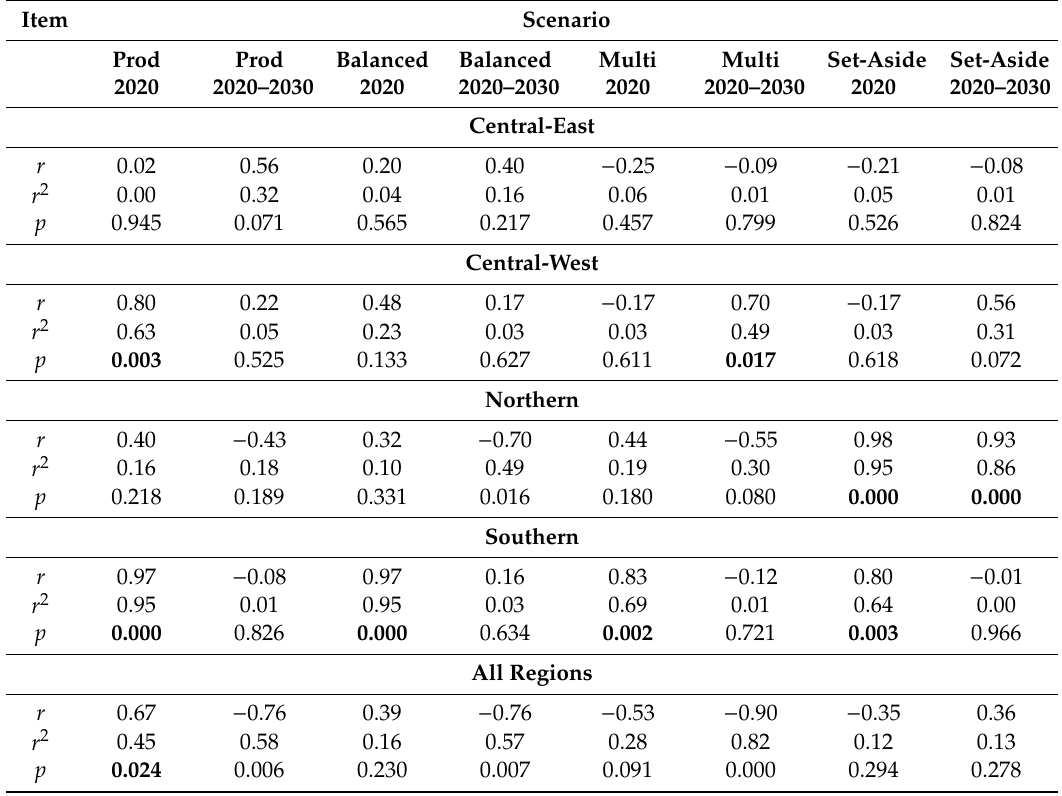
Table 6. Pearson correlation for the deviation of roundwood harvest and net forest emissions from the BAU-only scenario in the considered scenarios in 2000–2030 ( r ), coe ffi cient of determination ( r 2 ) and p -values for the correlation * (positive correlation implies that the increase in harvest occurs together with the increase in net forest emissions, and negative correlation implies that the increase in harvest occurs together with the reduction in net forest emissions). (Prod = production, Multi =